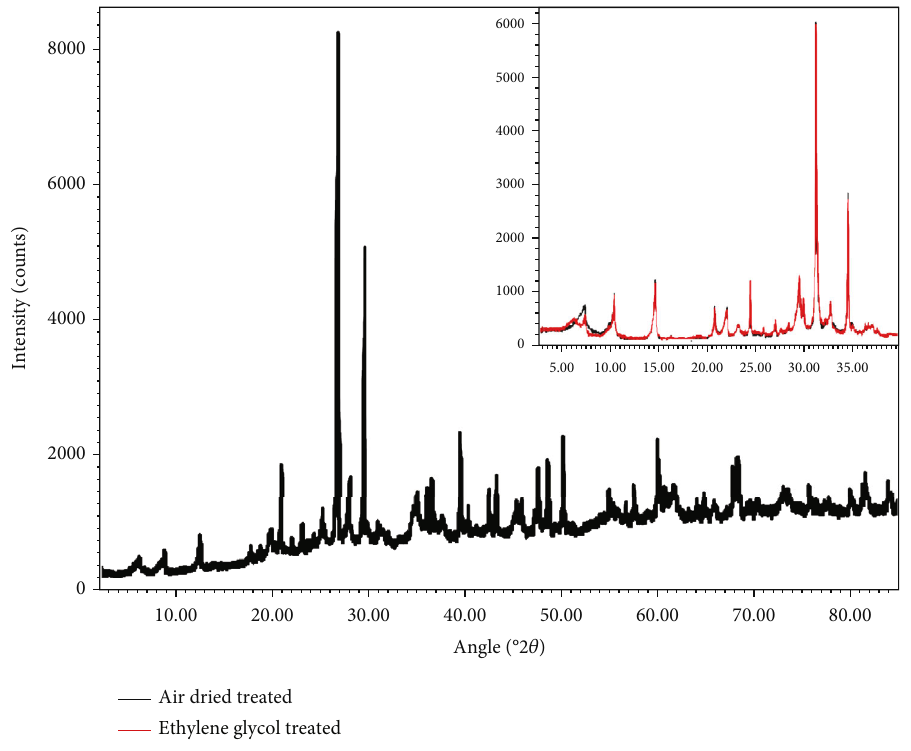
Figure 1: XRD pattern of random powder, air-dried, and EG